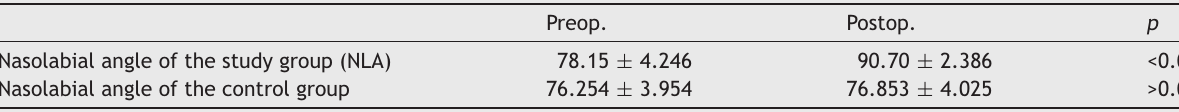
Nasolabial angles of the study and control group. Preop. Postop. p Nasolabial angle of the study group (NLA) 78.15 ± 4.246 90.70 ± 2.386 <0.001 Nasolabial angle of the control group 76.254 ± 3.954 76.853 ± 4.025